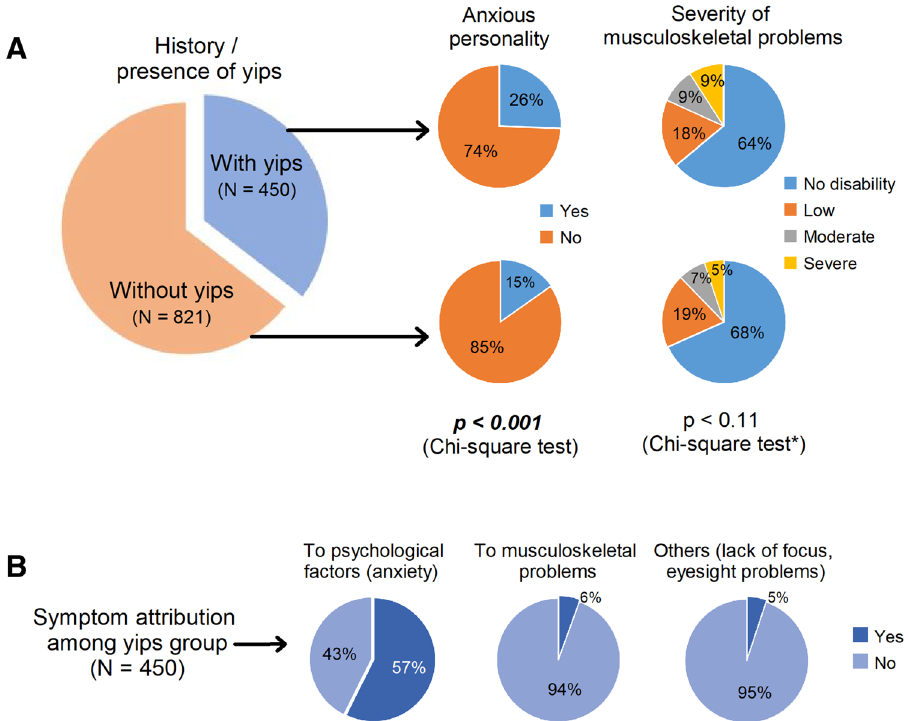
Figure 2. Response frequencies of golfers’ perception of yips. ( A ) Overview of classification of professional golfers. *Chi-square test represents the grading of at least one musculoskeletal problem (grades = none, low, moderate, severe) among the golfers. Significant differences were observed between normal and yips golfers having severe musculoskeletal problems ( χ 2 = 7.60, p = 0.006). ( B ) Degree of attribution of symptoms among respondents from yips-only